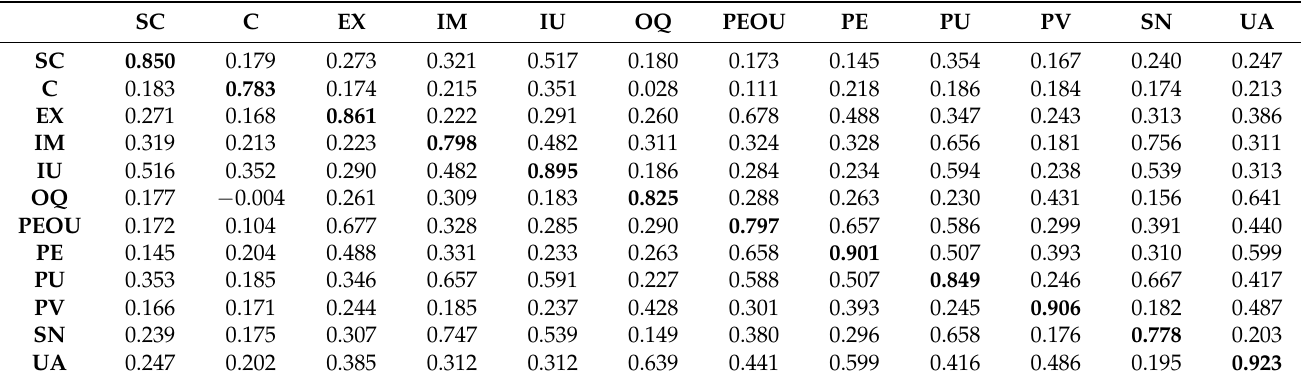
Table 3. Fornell–Larcker criterion and